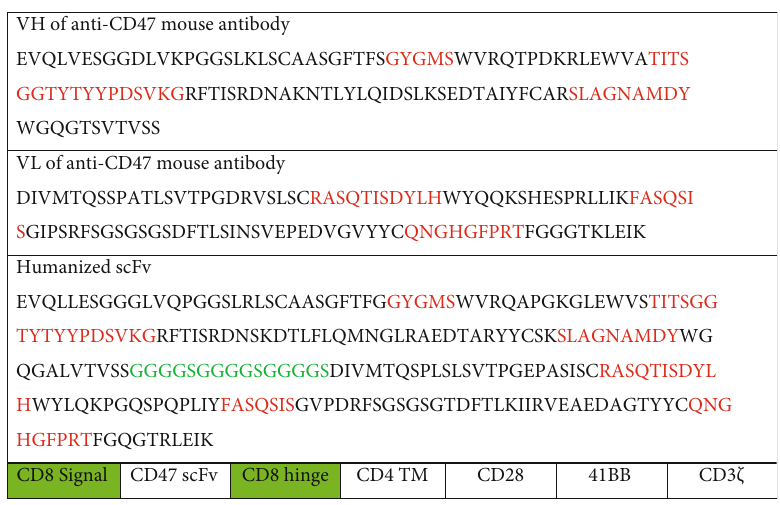
Figure 1: Amino acid sequence VH, VL of B6H12 mouse antibody; anti-CD47 humanized scFv antibody; and structure of chimeric antigen